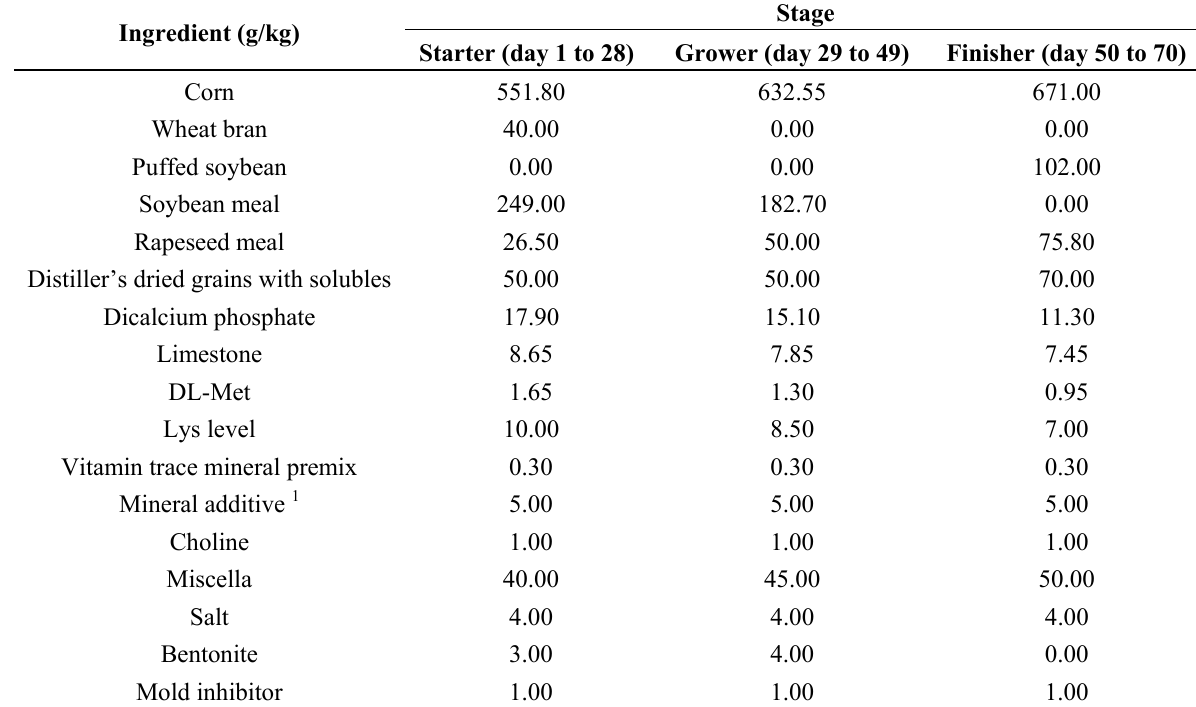
Table 4. Ingredients of starter, grower and finisher